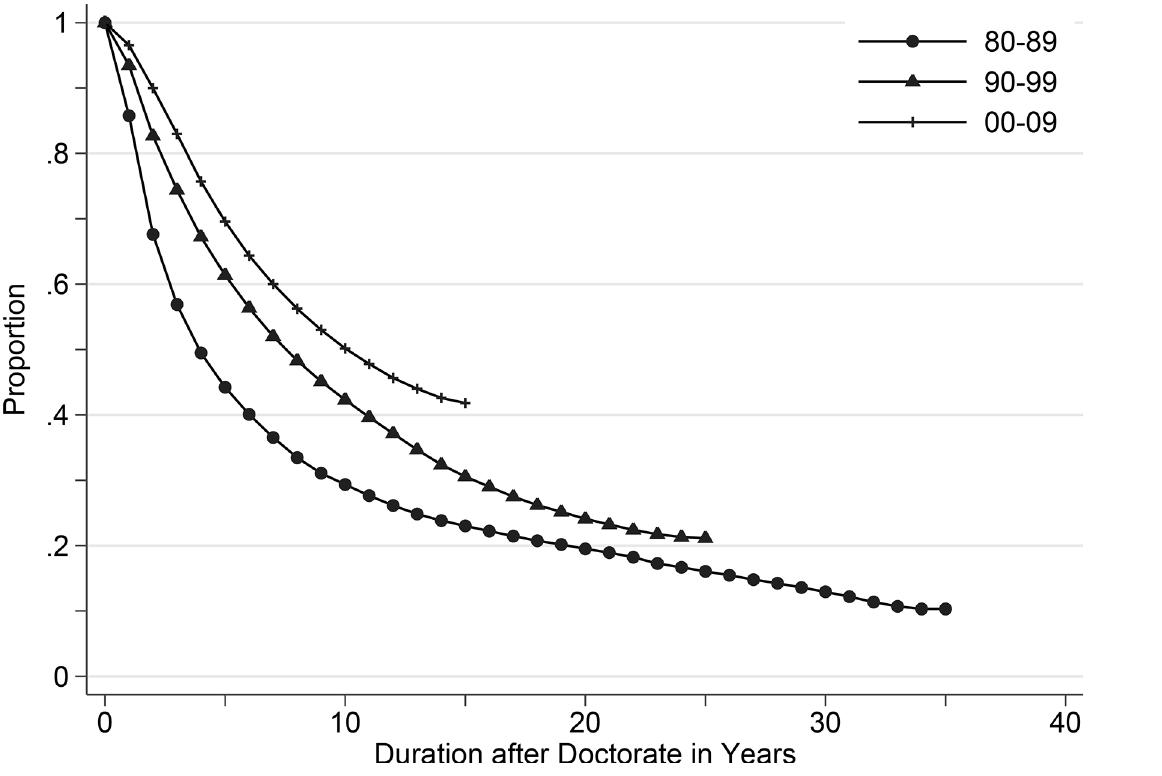
Fig 2. Proportion of Doctoral Degree Holders Not Hired as Tenure-Track Faculty, by Doctoral